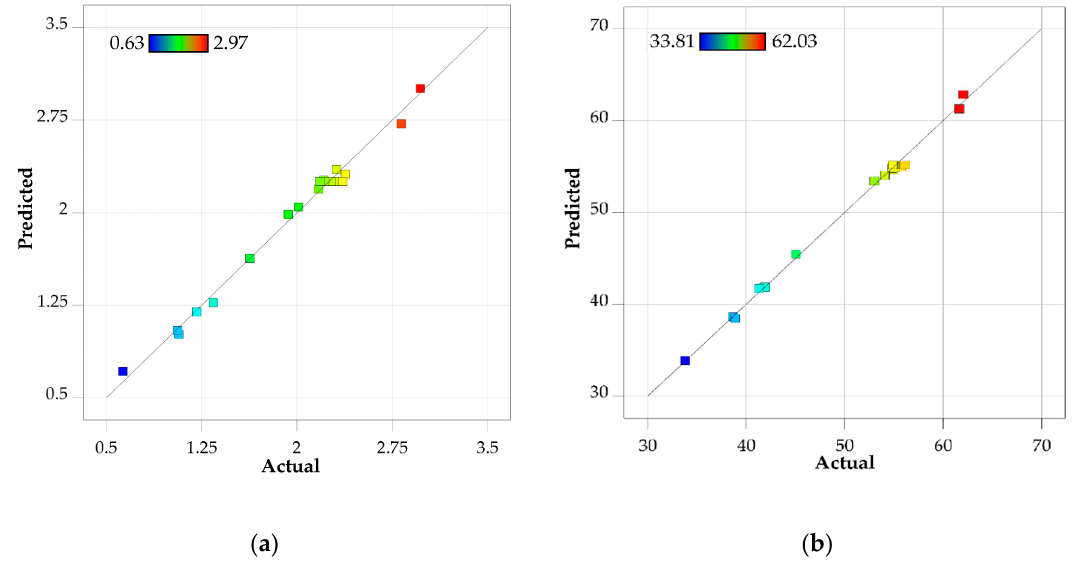
Figure 2. Relationship between predicted and observed values of ( a ) moisture contents (MC) and ( b ) Hunter Labs colorimeter color value (L*).